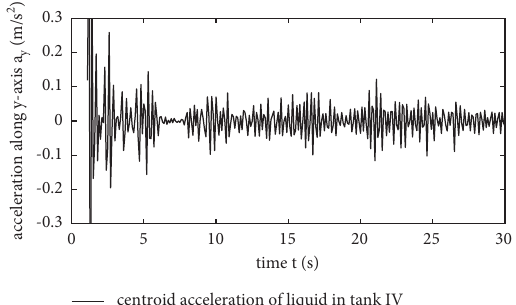
Figure 15: Acceleration curve of mass center of the liquid in tank IV.